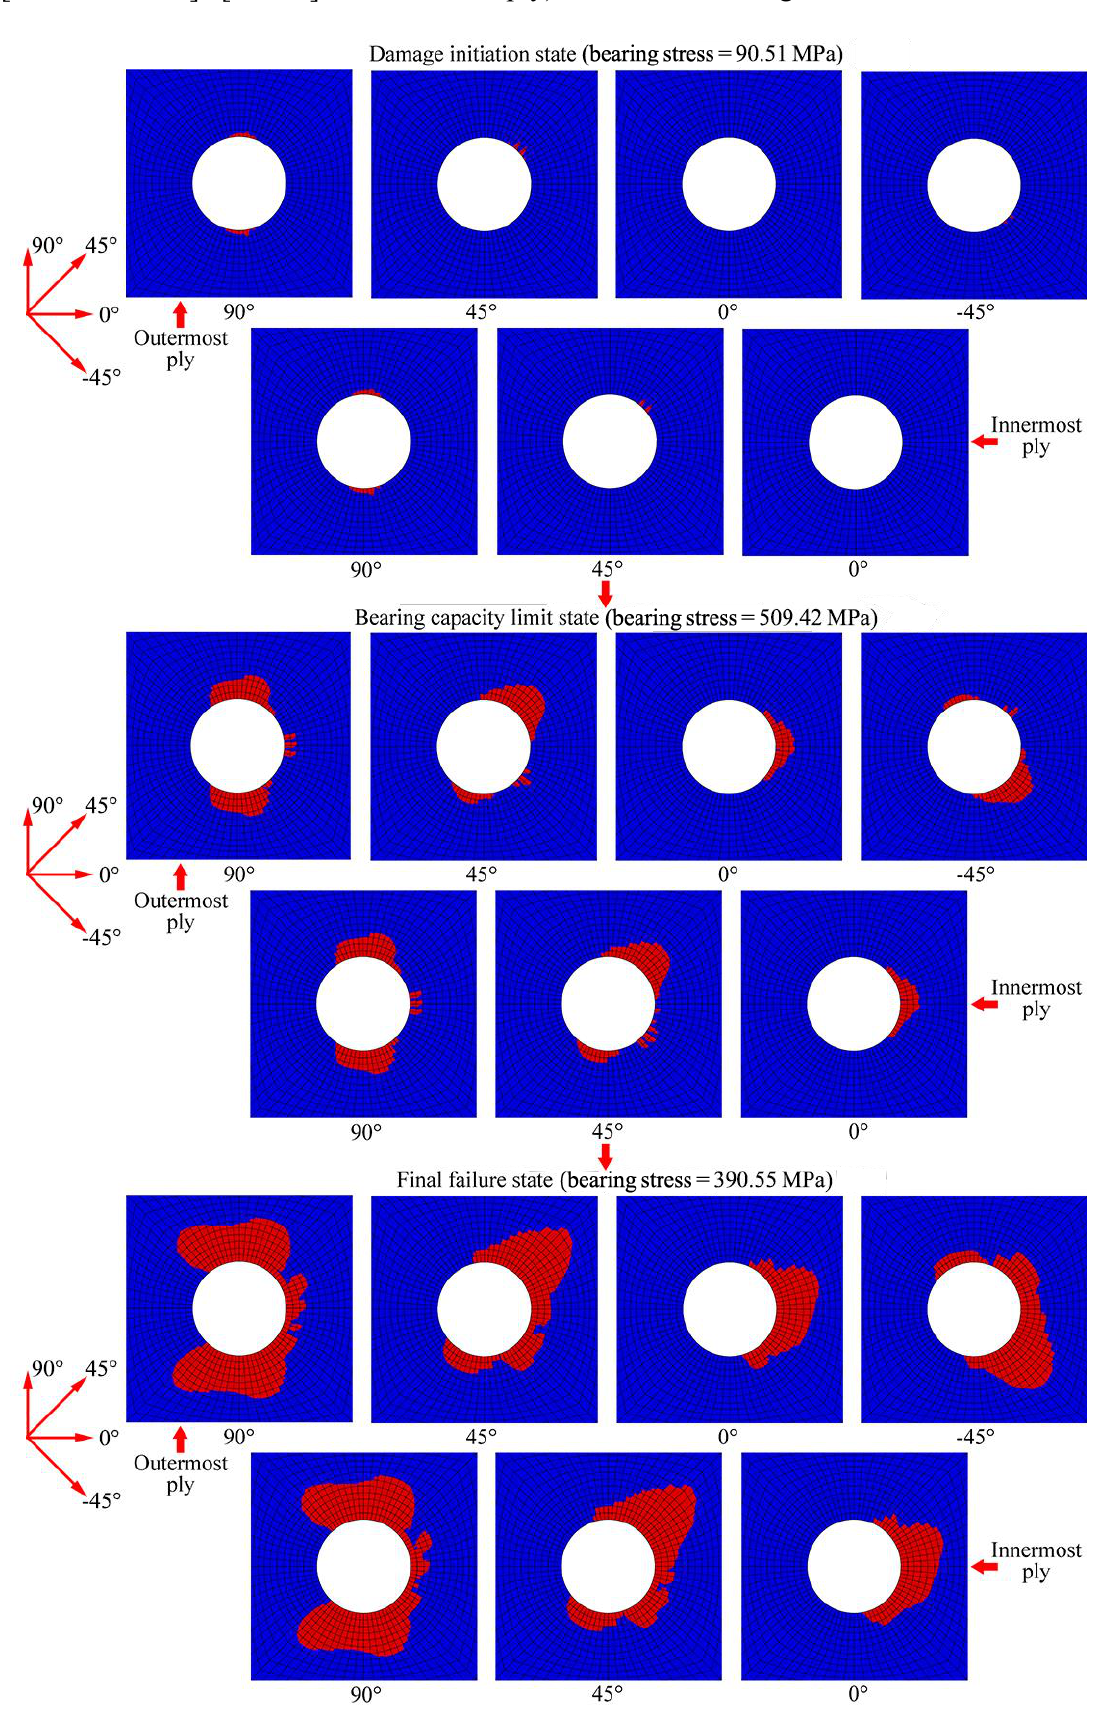
Figure 19. Illustration of matrix damage evolution at seven plies (sub-laminate [ 45 / 0 / 45 / 90]  , [45 / 90] and middle 0° ply) in different loading